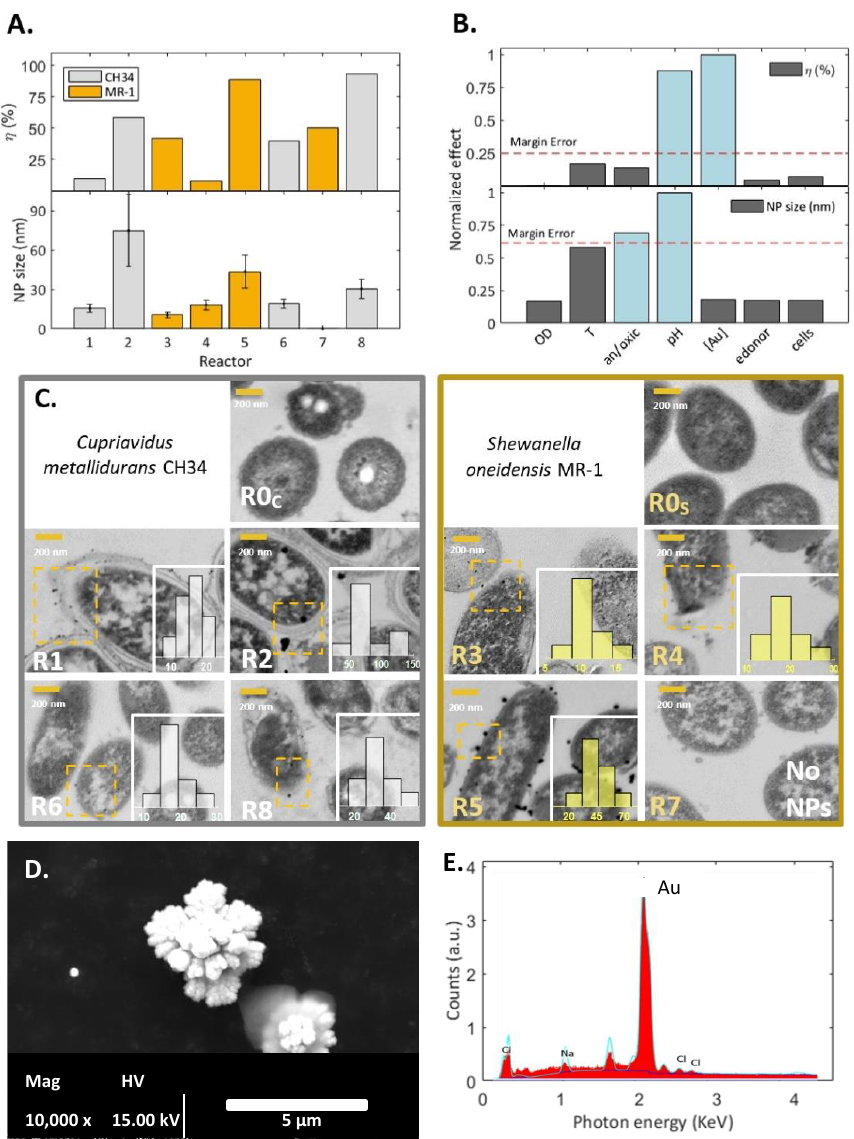
Figure 1. Fractional factorial (DOE) results for Au recovery and nanoparticle synthesis, ( A. ) gold removal efficiency (η Au ) and NPs size (NP size ) in the 8 reactors with conditions from an orthogonal array of 7 factors (cell concentration, temperature, anoxic/oxic conditions, pH, initial gold concentration, electron donor type, bacterial species). ( B. ) Pareto chart of the effect of each factor for response variable η Au and NP size . Effect values are normalized from 0 to 1, by considering the effects quotient of the most significant effect. Significant effects lie out of the margin error. ( C. ) TEM analysis and NPs size distribution (nm) for the 8 reactors (R1-8) and bacterial controls without metals (R0c and R0s) for C. metallidurans CH34 (gray) and S. oneidensis MR-1 (yellow). R7 ( D. ) SEM characterization of AuNPs in suspension and ( E. ) EDX.